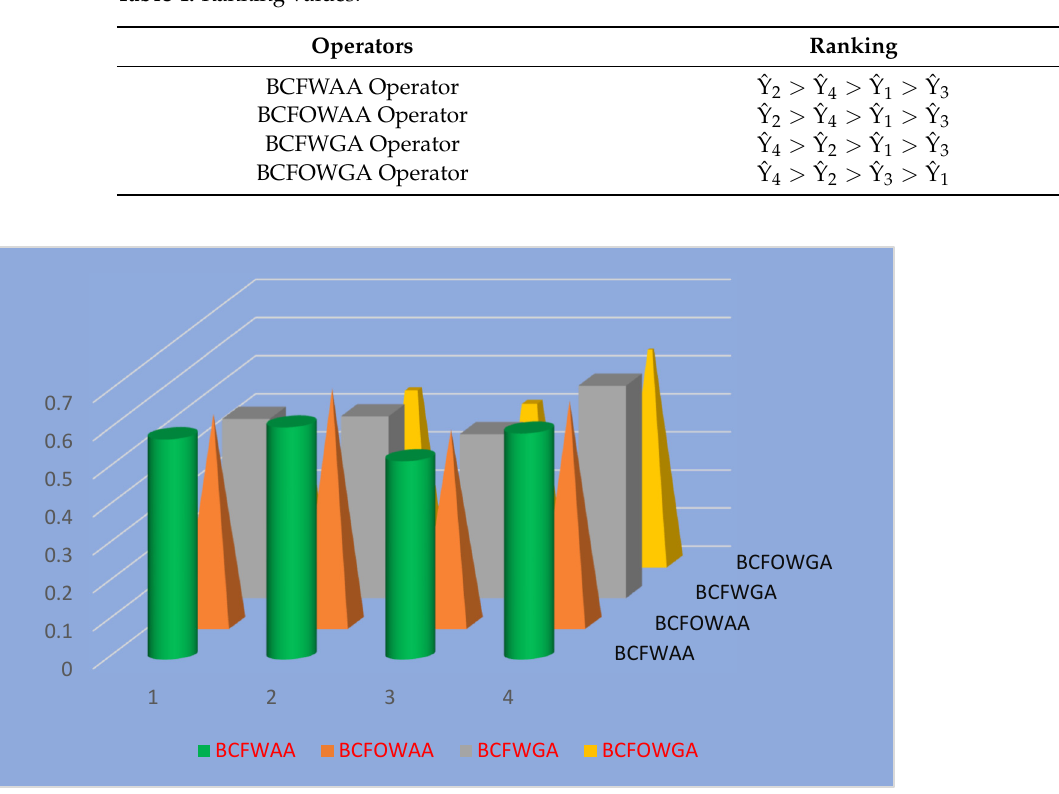
The ranking results for any four different types of operators are described in Table 4